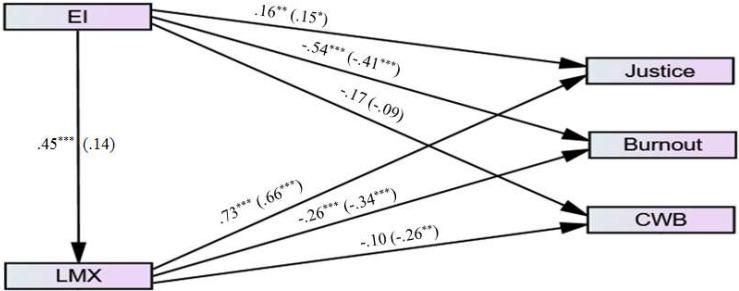
Path diagram for male group (n = 117) and female group (n = 126; in parenthesis), study 2. *p < 0.05, **p < 0.01, ***p < 0.001. χ2(df) = 1.04 (2), p = 0.595, χ2/df = 0.52, SRMR = 0.01, CFI = 1.00, GFI = 0.99, NFI = 0.99, ECVI = 0.23, RMSEA (90% CI) = 0.00 (0.00–0.11), p-close = 0.745.